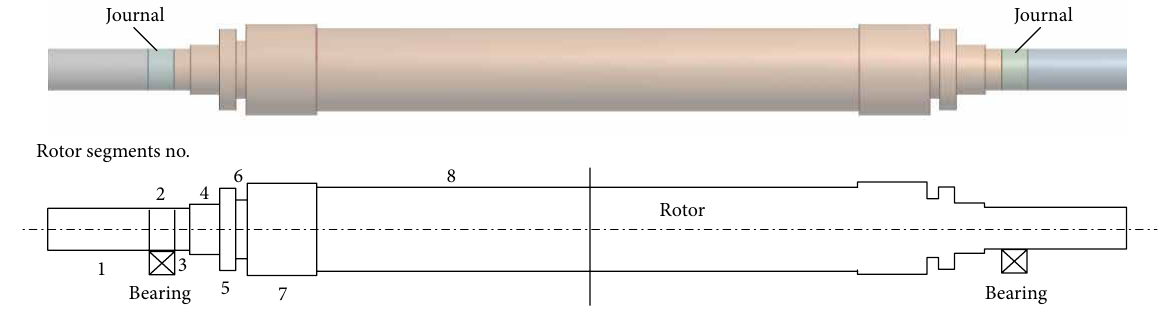
Figure 5: Simplified model of a generator